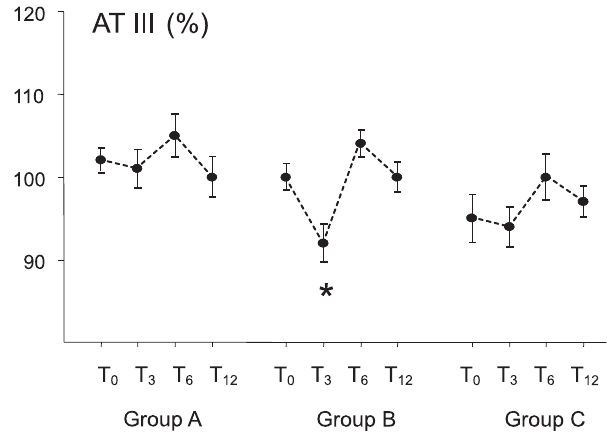
Figure 1 - Antithrombin III (AT-III) levels (mean ± standard error) during one year of hormone therapy in patients receiveing oral CEE (group A), oral CEE plus MP (group B), or transdermal 17 β -estradiol plus MP (group C). * = p < 0.05, compared to initial